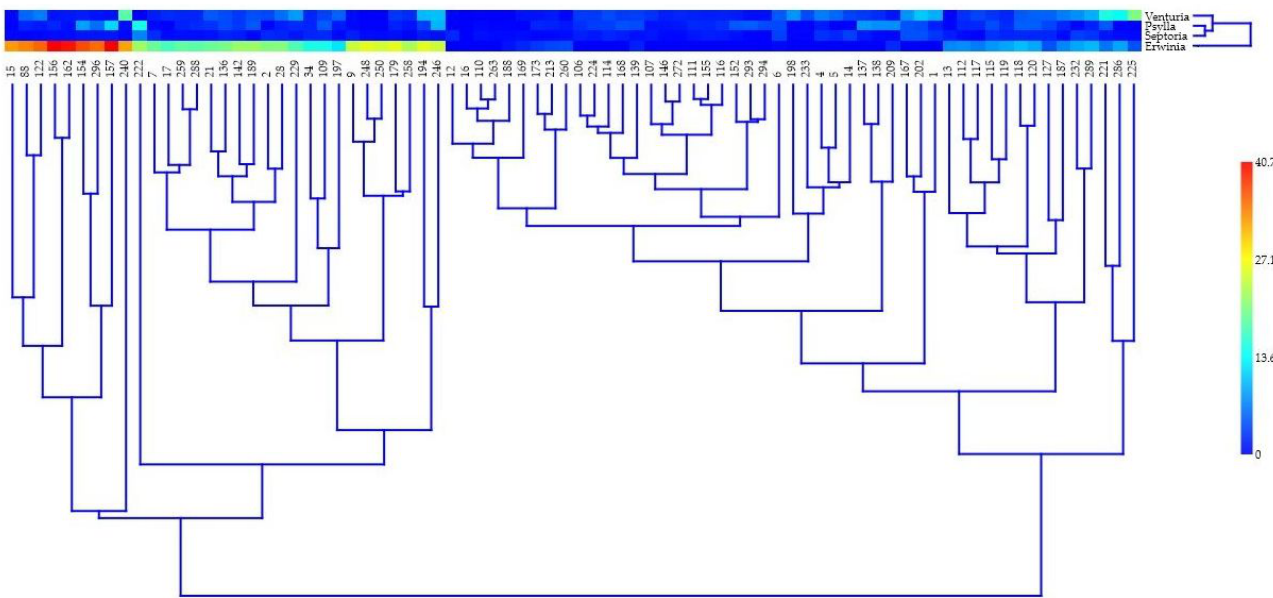
Figure 2. Multivariate analyses performed for 80 pear genotype response as the degree of attack ( DA %) to three pathogens (pear scab— V. pyrina , septoria— S. pyricola , and fire blight— E. amylovora ) and Psylla pest assault, using hierarchical clustering, the paired group method (UPGMA—unweighted pair group method with arithmetic mean), and similarity indexes (Euclidean). The genotype codes (numbers) correspond to the names of species and Romanian and non-Romanian cultivars from Tables 1–3, i.e., between 1 and 17 are Pyrus species, between 21 and 120 are Romanian cultivars, and between 122 and 296 are non-Romanian cultivars from the international assortment.